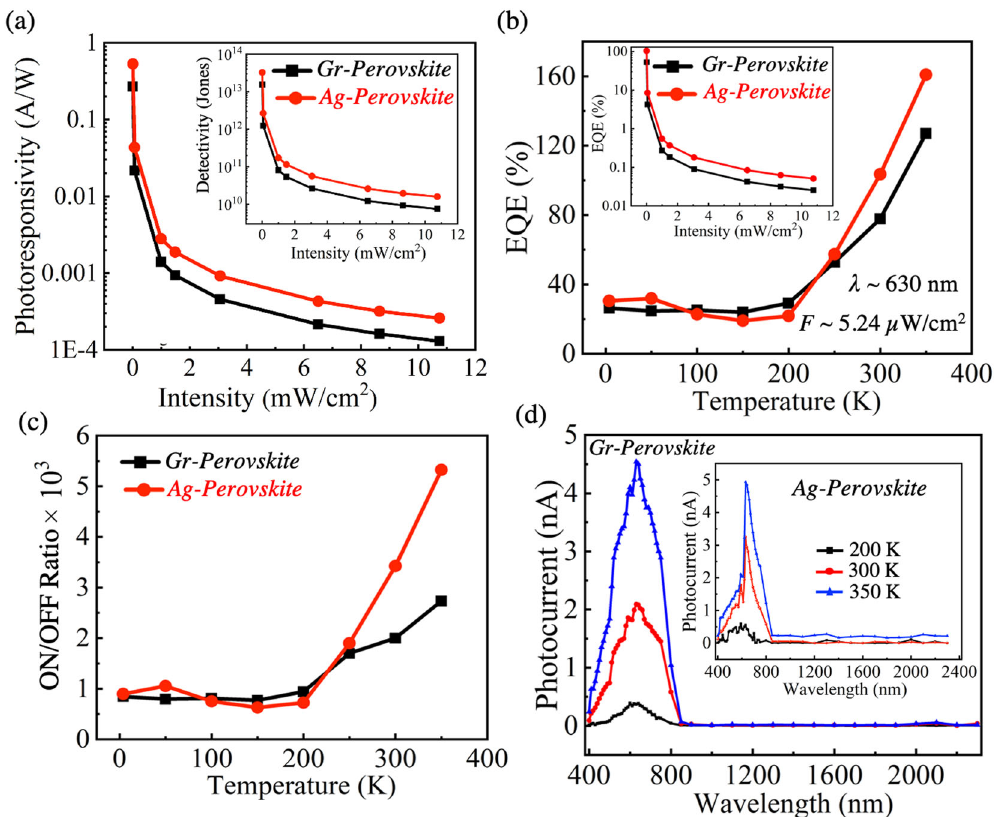
Fig. 4 Device fi gures of merit for the 2D perovskite PD. a R as a function of F , where the highest R was found to be ~0.27 and 0.53 A/W at F ~ 5.24 μ W/cm 2 (0.00524 mW/cm 2 ) for Gr-perovskite and Ag-perovskite PDs, respectively. The inset shows D as a function of F , where D was calculated to be ~1.55 × 10 13 Jones and 3.24 × 10 13 Jones for Gr-perovskite and Ag-perovskite, respectively. b The EQE as a function of T (~4 – 350 K). The EQE increases considerably with increasing T , and at room temperature, EQE was determined to be ~78% and 103% for the Gr- perovskite and Ag-perovskite PDs, respectively. The inset shows the EQE as a function of F for both PDs. c ON/OFF ratio comparison for both PDs at T ~ 4 – 350 K. At ~300 K, the ON/OFF ratios were ~2 × 10 3 and 3.4 × 10 3 for Gr-perovskite and Ag-perovskite PDs, respectively. d The I p as a function of λ for the Gr-perovskite PD, while the inset shows the corresponding I p versus λ for the Ag-Perovskite PD at T ~ 200, 300, and 350